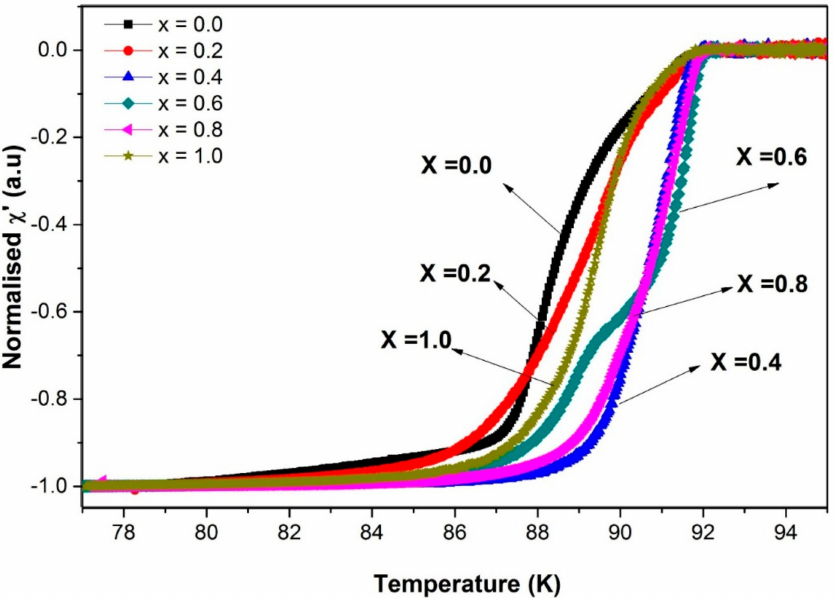
Figure 7. The real part of the normalised susceptibility curve for Y-123 with x = 0.0, 0.2, 0.4, 0.6 0.8, and 1.0 wt.% SnO 2